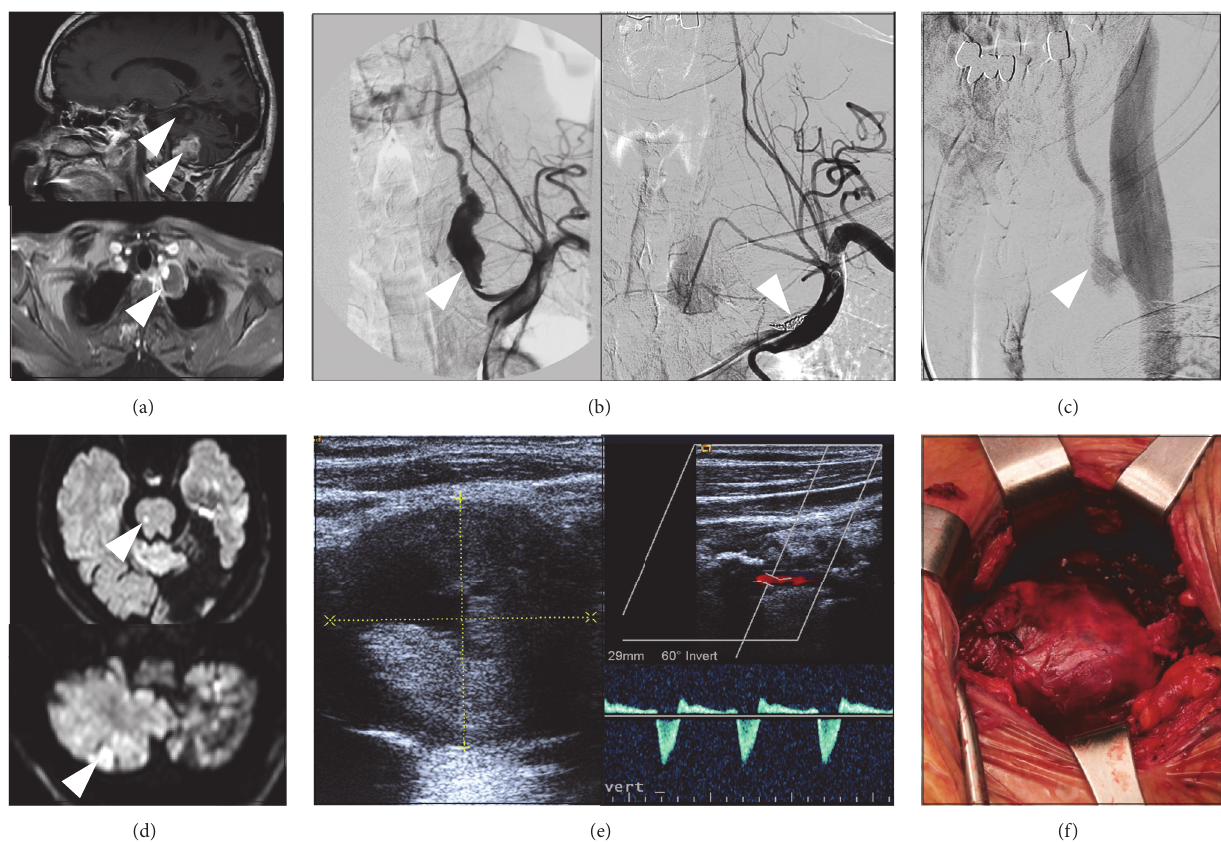
Figure 1: (a) (Top) sagittal T1-weighted contrast enhanced brain magnetic resonance imaging (MRI) scan showing a subacute ischemic lesion of the inferior left cerebellar hemisphere in the left posterior-inferior cerebellar artery (PICA) territory and chronic cerebellar and occipital ischemic lesions; (bottom) axial T1-weighted contrast enhanced MRI image of the neck showing a giant fusiform aneurysm (arrow), containing an eccentric thrombotic formation, originating from the left vertebral artery. (b) Left subclavian angiograms showing (left) the displasic and tortuous aspect of the giant aneurysm and (right) aneurysm exclusion after the endovascular treatment by deposition of GDC vortex spirals in the proximal segment of left vertebral artery (VA) (arrow). (c) Late sequences of right vertebral angiogram performed six years after the endovascular procedure showing full revascularization of the rostral part of the aneurysm by retrograde blood flow from the patent vertebrobasilar axis. (d) Diffusion-weighted imaging (DWI) brain MRI showing new acute ischemic lesions of the cerebellum and the brainstem (arrows). (e) Sonography and Color Doppler Ultrasound of neck vessels showing the aneurysm (3.5 cm) and the biphasic flow in the left vertebral artery supportive of the embolic etiology of the new ischemic stroke. (f) Surgery of the giant aneurism by aneurysmorraphy with thrombectomy: aneurysm exposure and isolation from the surrounding